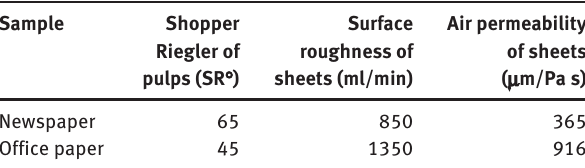
Table 1: Some properties of pulps and resultant papers. Sample